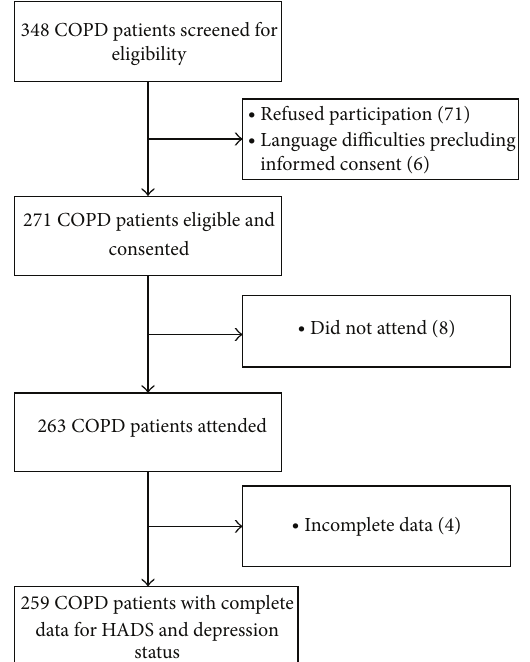
Figure 1: Flowchart of chronic obstructive pulmonary disease (COPD) patients in the study.